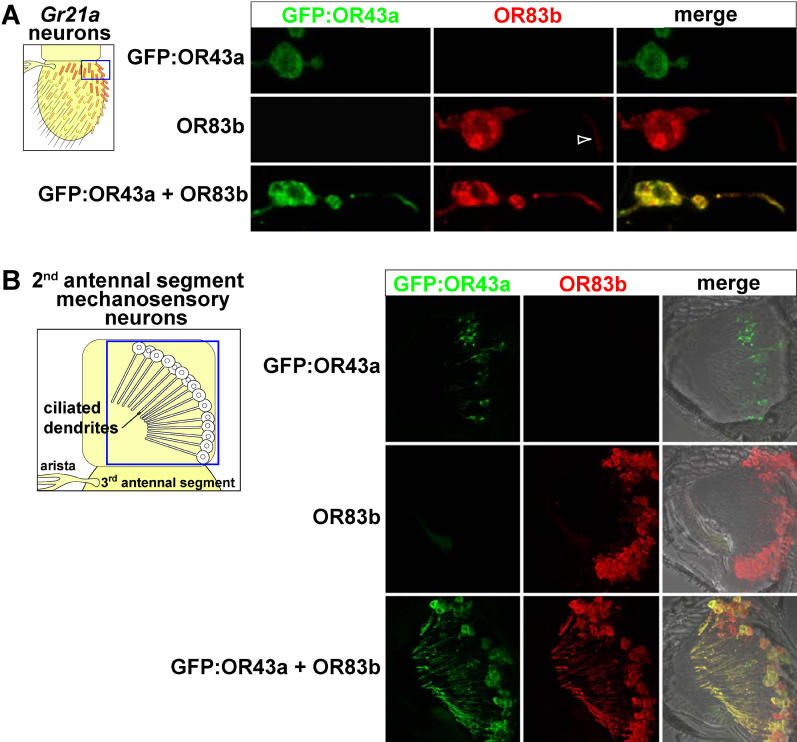
OR83b Is Necessary and Sufficient to Mediate OR Localization to Ciliated Dendrites in Other Sensory Neurons(A) Immunostaining for GFP:OR43a (α-GFP, green) and OR83b (red) when misexpressed singly or in combination in Gr21a neurons. These animals are homozygous mutant for Or83b, which allows visualization of protein distributions specifically in Gr21a neurons. The arrowhead marks very weak localization of OR83b to cilia when expressed alone. Genotypes: Top row: Gr21a-Gal4/UAS-GFP:Or43a;Or83b1/Or83b2. Middle row: Gr21a-Gal4/+;UAS-Or83b,Or83b1/Or83b2. Bottom row: Gr21a-Gal4/UAS-GFP:Or43a;UAS-Or83b,Or83b1/Or83b2.(B) Immunostaining for GFP:OR43a (α-GFP, green) and OR83b (red) when misexpressed singly or in combination in second antennal segment mechanosensory neurons using the ciliated cell-specific oseg2-Gal4 driver. OR83b shows extremely weak localization to cilia that is not visible under these imaging conditions. Merged images are overlaid on a bright-field image to visualize tissue morphology. Genotypes: Top row: oseg2-Gal4/UAS-GFP:Or43a. Middle row: oseg2-Gal4/+;UAS-Or83b/+. Bottom row: oseg2-Gal4/UAS-GFP:Or43a;UAS-Or83b/+.